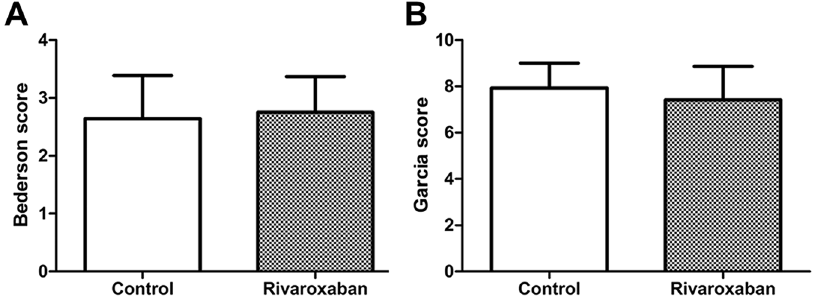
Figure 2. No difference in Neurological outcome under Rivaroxaban treatment post-ET. ( A ) Bederson scale score in 30 mg/kg Rivaroxaban-pretreated rats (n = 12) is 2.75 ± 0.18 and diabetic control rats (n = 12) is 2.64 ± 0.20, without significant difference (unpaired t -test, P = 0.70). ( B ) Garcia scale score in 30 mg/kg Rivaroxaban-pretreated rats (n = 12) is 7.42 ± 0.42 and diabetic control rats (n = 12) is 7.93 ± 0.29, not significantly different (unpaired t -test, P =